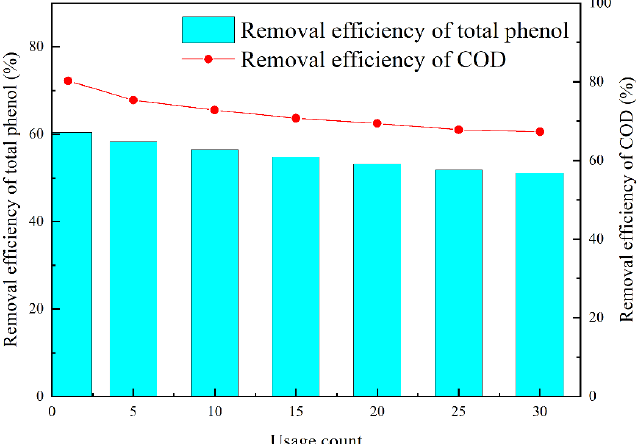
Figure 5. Degradation efficiency of continuous use of catalyst with pH of 7.05, catalyst dosage of 30 g/L and ozone dosage of 2.5 g/h.